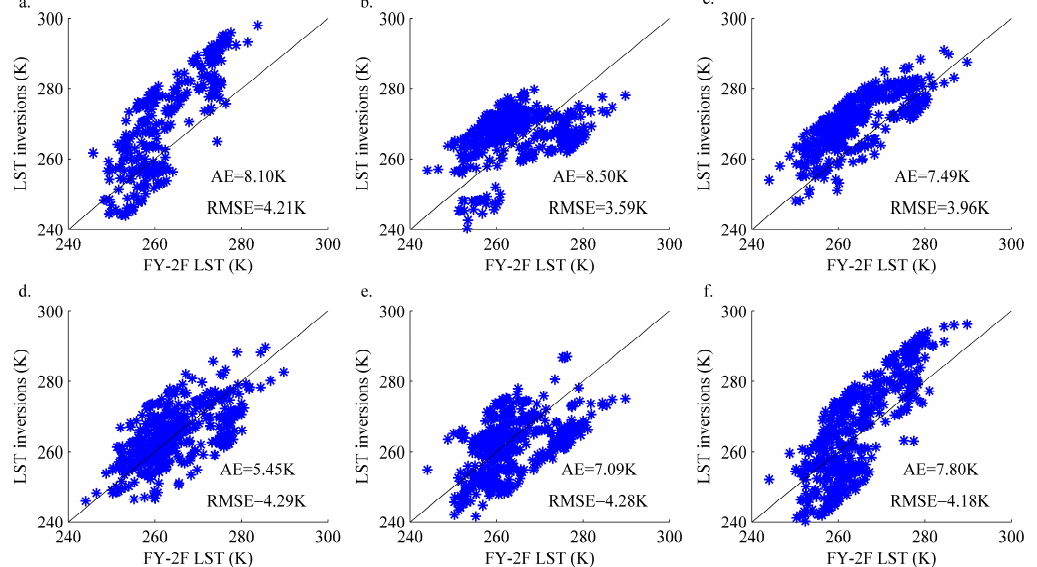
Figure 4. The accuracy analysis of Moon-based LST estimations compared with Fengyun 2 (FY-2) F thermal infrared data, representing the results of ( a ) 6.9, ( b ) 10.8, ( c ) 18.7, ( d ) 23.8, ( e ) 36.5 and ( f ) 89.0 GHz channels.